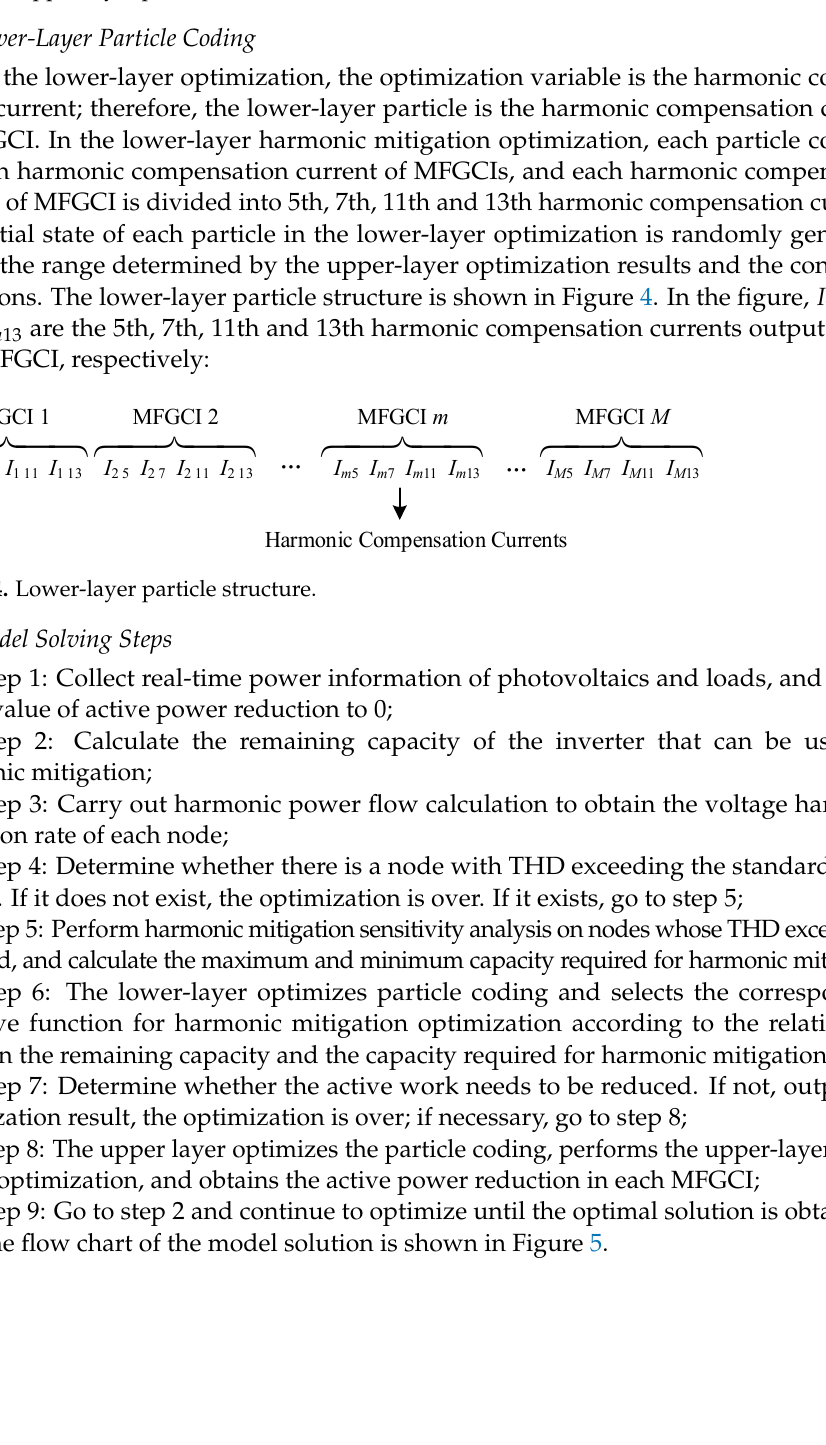
Figure 3. Upper-layer particle structure.